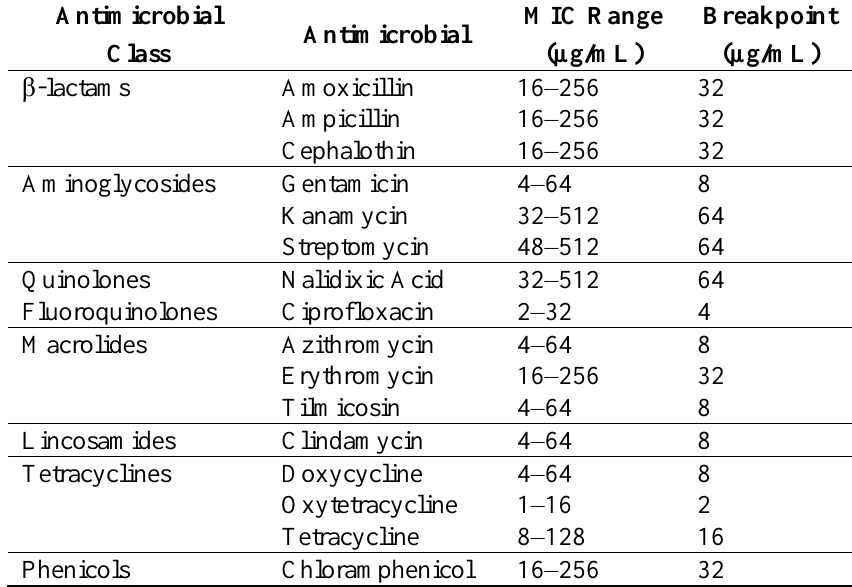
Table 2. A list of the sixteen tested antimicrobials, their classes, the concentrations used for susceptibility testing, and the breakpoints used for each